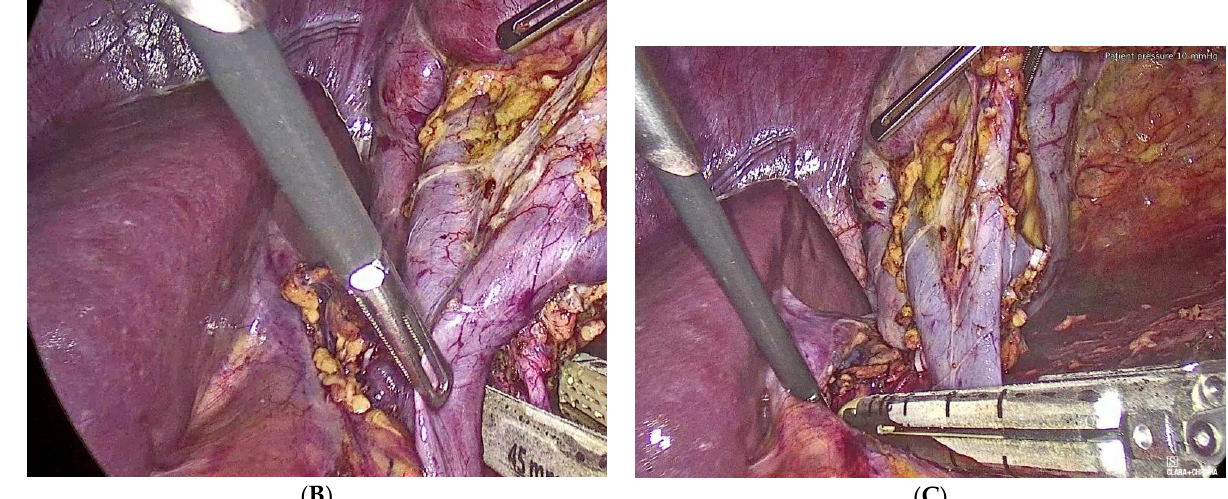
( B ) Figure 3. Port placement for laparoscopic donor nephrectomy (LDN). ( A ) Ligation of the ureter. ( B ) Ligation of the renal vessels. 3. Results For this study, the following data were collected: age, sex, BMI, relation to recipient, operative time (OT), side of operation, perioperative bleeding, prior abdominal surgery,